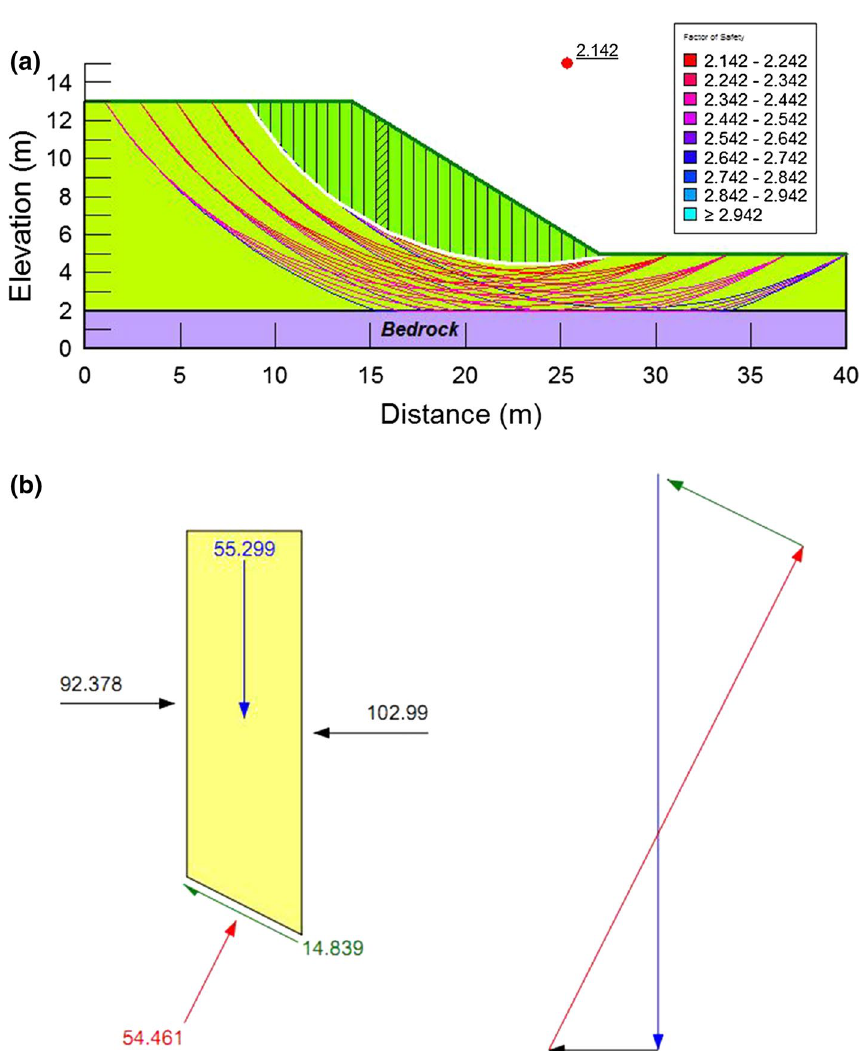
Table 2 The information of the 12th slice for the state � = 14 ◦ , C = 25kN/m 2 , 𝛾 = 15kN/m 3 , 𝛽 = 30 ◦